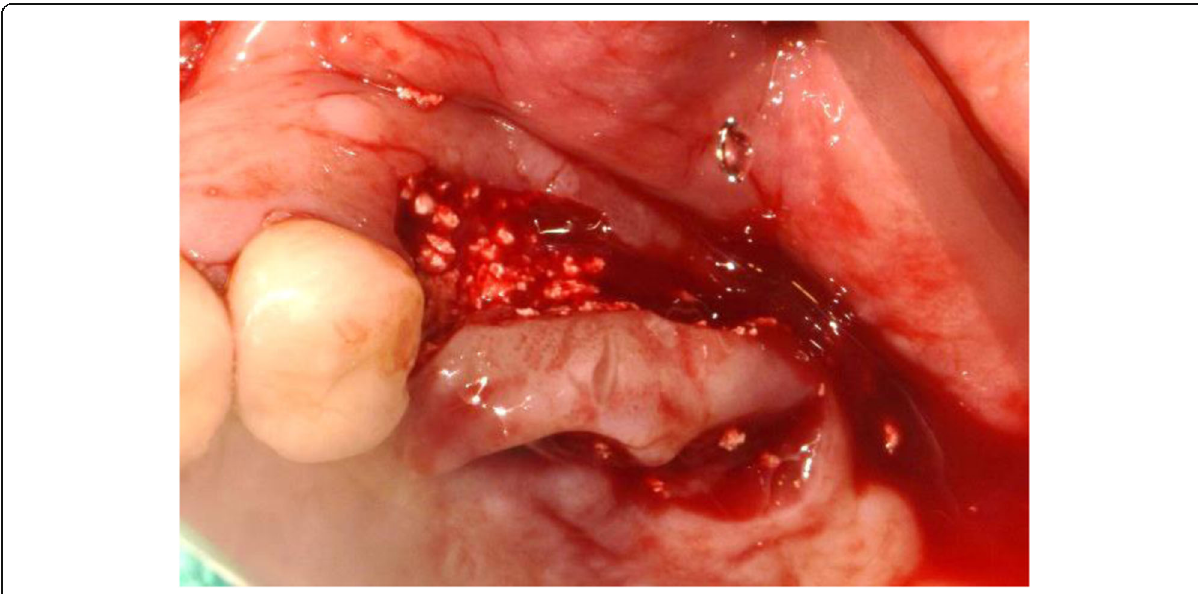
Fig. 1 Clinical photo taken right after flap operation of explantation at the local dental clinic